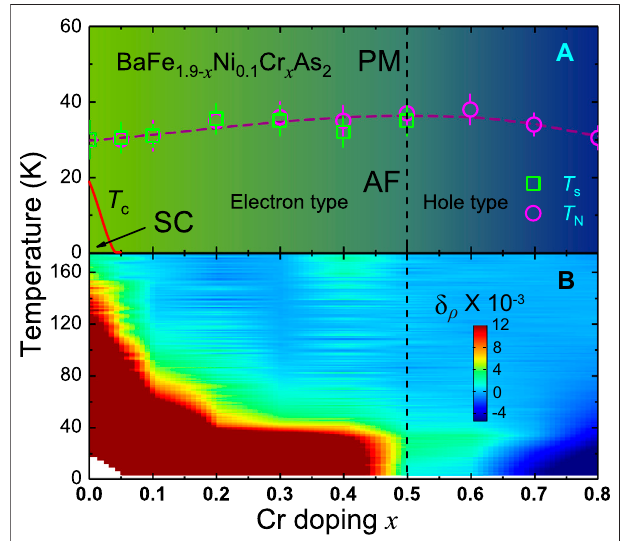
FIGURE 1 | (Color online) Phase diagram and in-plane resistivity anisotropy of BaFe 1.9 − x Ni 0.1 Cr x As 2 . (A) The PM, AF, and SC mark the region of paramagnetic, antiferromagnetic, and superconducting phases de fi ned by T s , T N , and T c , respectively. Here, T s and T N were measured by neutron diffraction in our previous work on the naturally twinned samples [73]. (B) The gradient color maps the in-plane resistivity anisotropy δ ρ measured on detwinned samples. The vertical dashed line divides the regions for electron- type and hole-type charge carriers as determined by the sign of Hall and Seebeck coef fi cients